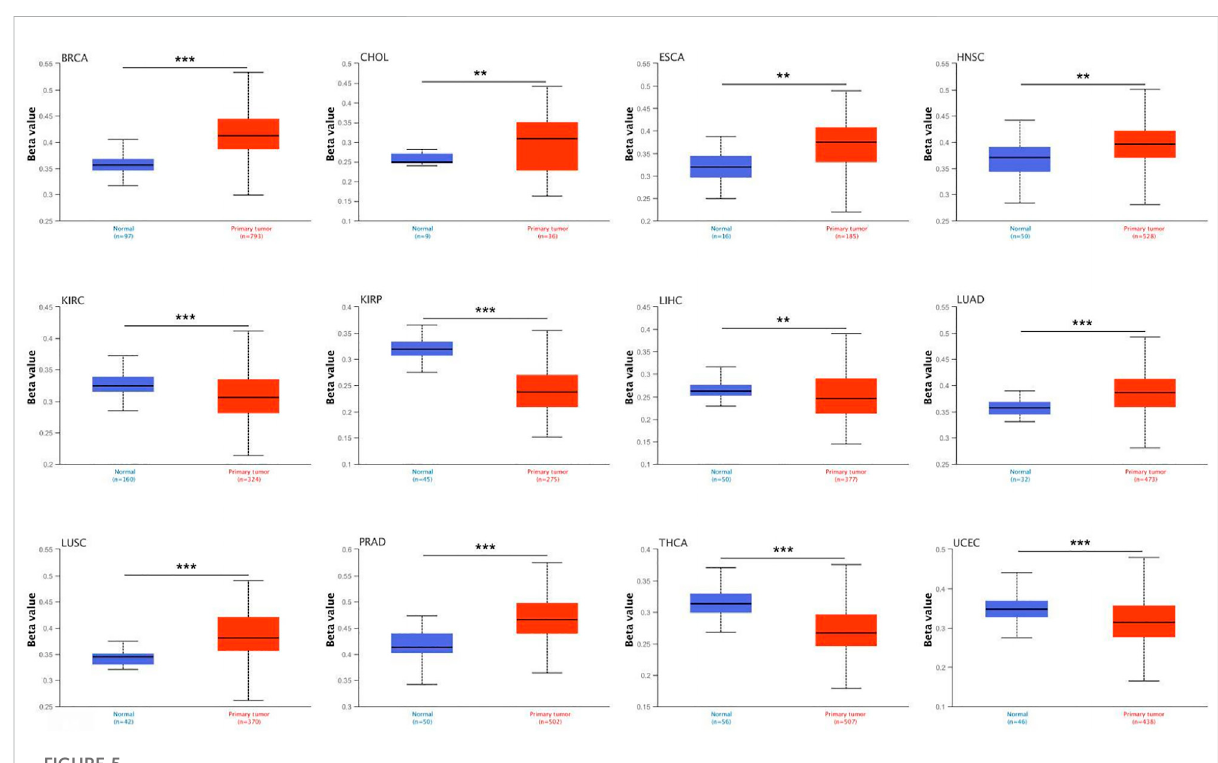
FIGURE 5 CLU promoter methylation in pan-cancer. Data came from UALCAN